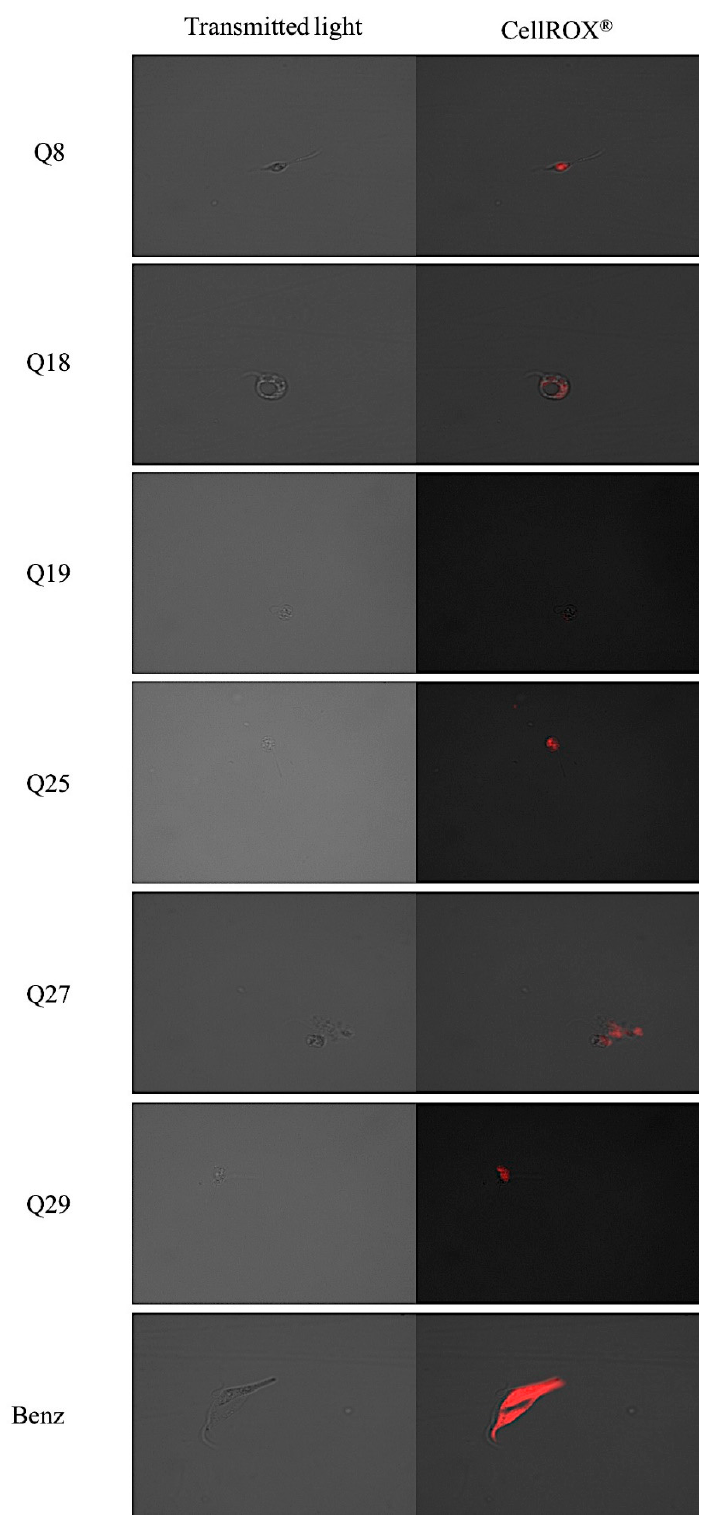
Figure 5. Reactive oxygen species detection by CellROX ® Deep Red staining. Results after 24 h of incubation with the IC 90 of acrylonitriles. Red staining corresponds to ROS production inside the cytoplasm of the epimastigotes. Images were captured using an EVOS FL Cell Imaging System (100×). Scale-bar : 10 µm. Benz: benznidazole.